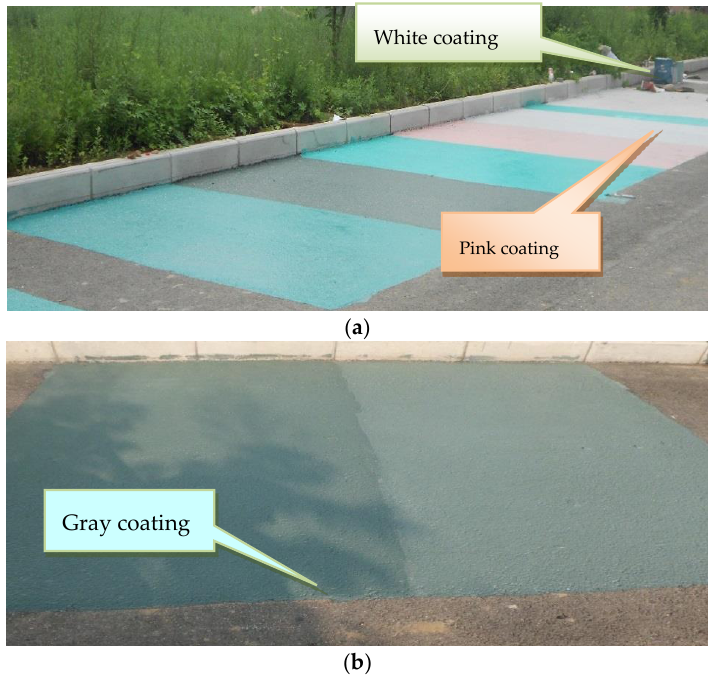
Figure 2. Heat-reflective coatings for asphalt pavement applied in this study included the white and pink coatings shown in ( a ), and gray coating shown in ( b ).